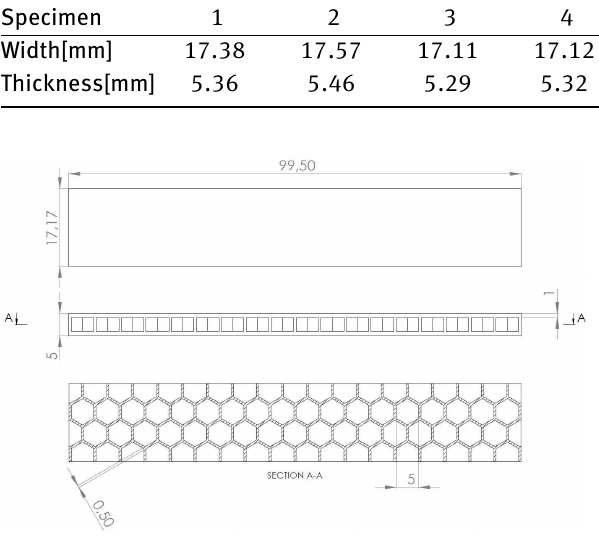
Figure 1: Nominal geometrical data of specimens 1-5, 7 and